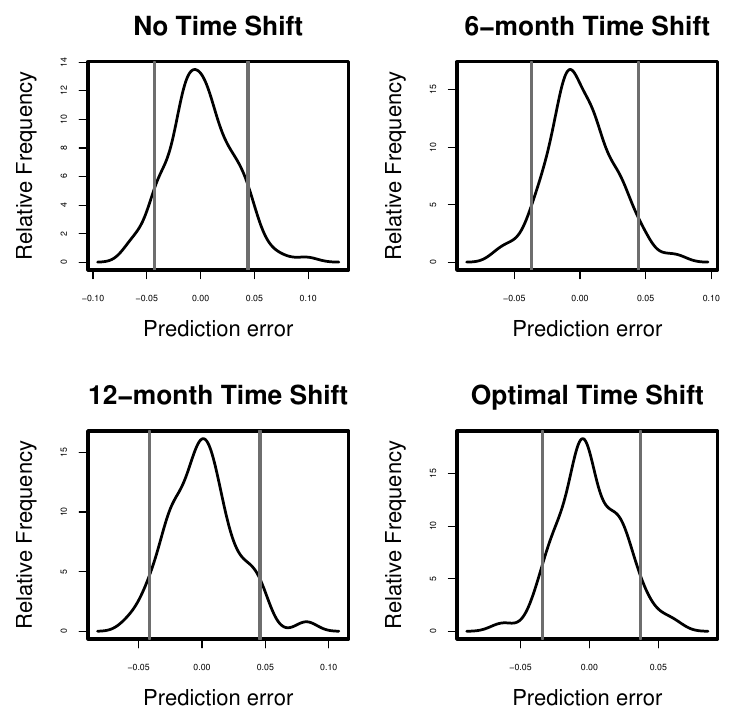
Figure 11. Prediction error distribution with 5% and 95% quantiles (grey vertical lines) for the models with no time shifts ( top left ), 6.month time shift ( top right ), 12-month time shift ( bottom left ) and optimal time shifts ( bottom right